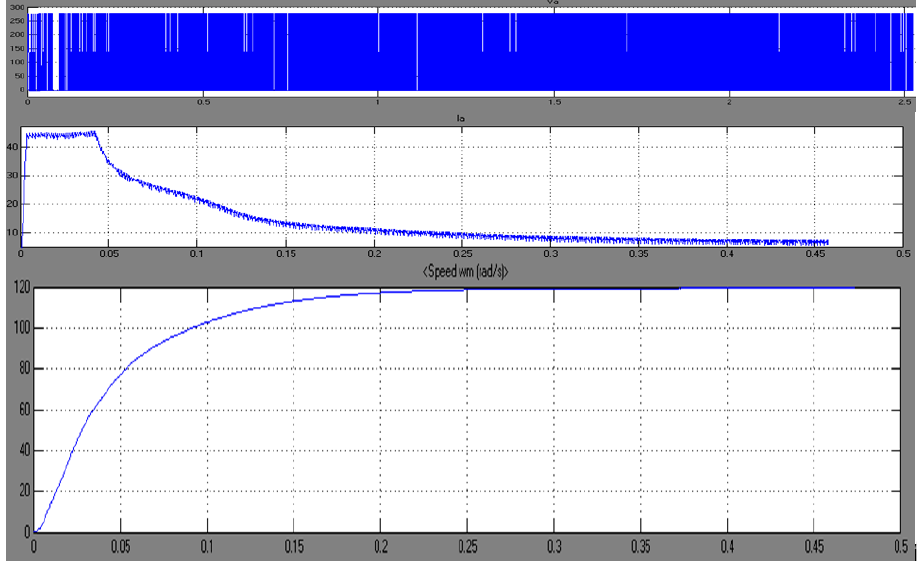
Figure 14. Simulation results of novel PSO fuzzy for SEDC